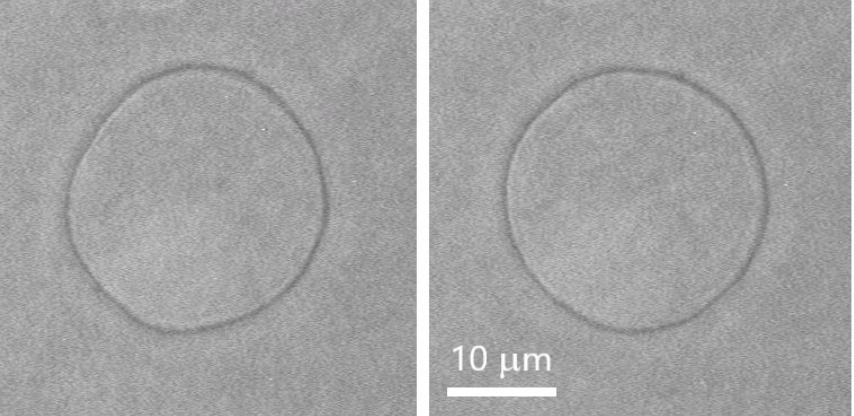
Figure 1. Phase contrast micrographs of POPC vesicle with radius 11.8 µm in 1 mM L-Glu, 50 mM Tris-HCl, pH 7.2; two subsequent images captured at 1 frame per second; scale bar corresponds to 10 µm.